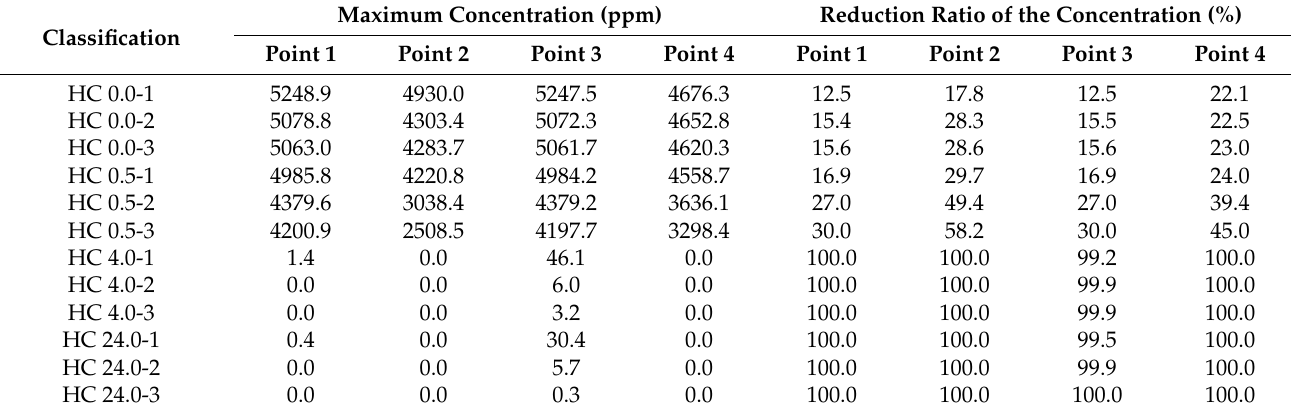
Table 5. FDA results for high-TPH condition.